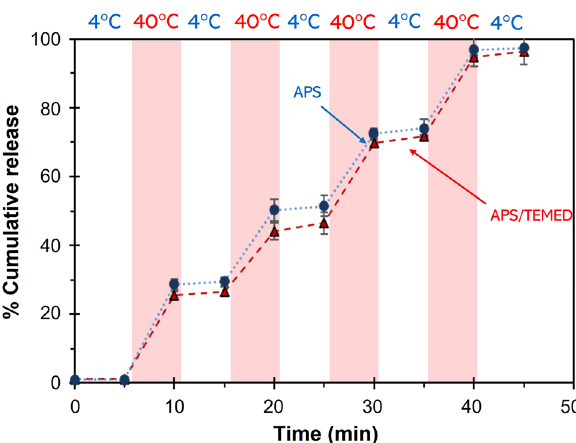
Figure 11. Switchable release profiles of